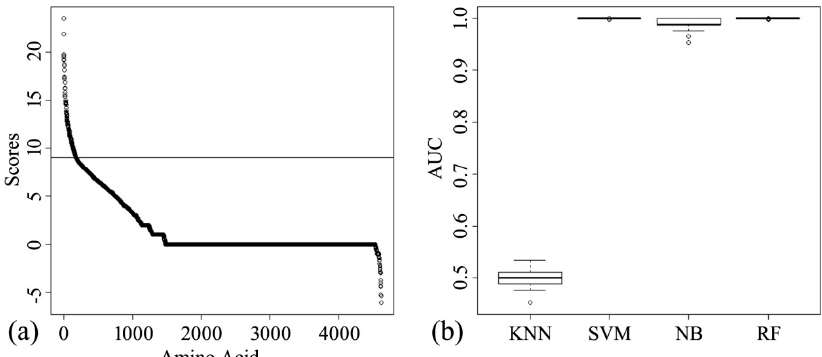
Figure 1. Importance score curve and the performances of k -nearest neighbor (KNN), support vector machine (SVM), naïve Bayes (NB), and random forest (RF) classifiers. ( a ) The ranked scores were calculated from five AA factors using the random forest method. The x and y coordinates denote the total length of the 11 protein alignments and the importance scores, respectively. The cutoff value (9) is indicated by the thin horizontal line. ( b ) Performances of the four classifiers were evaluated from 100 repeats of 10-fold cross-validation. The area under the curve (AUC) ranges from 0 to 1.